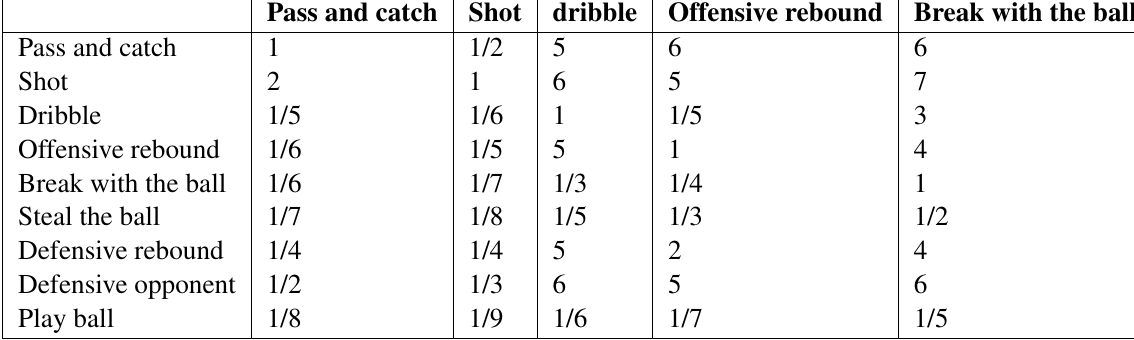
Table 6 Judgment matrix of the importance of indicators.